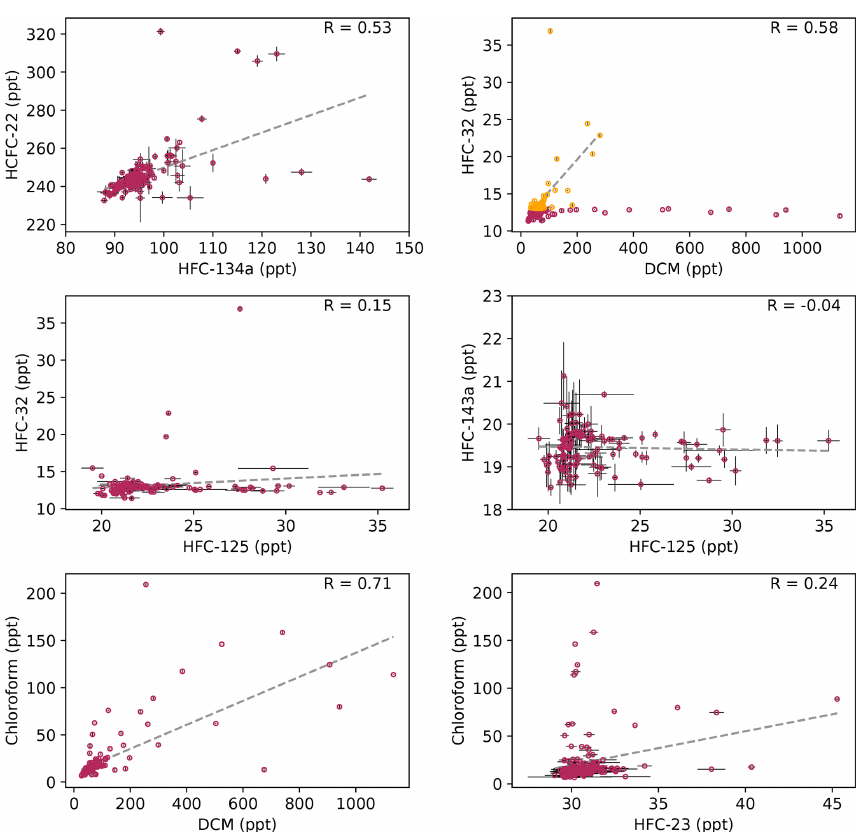
Figure 3. Halocarbon scatter plots, shown with line of best fit and Pearson ( R ) correlation coefficient. For HFC-32 versus DCM, the sub- scatter shown in orange is a subset of the dataset corresponding to samples whose HFC-32 mole fraction (lower bound of measurement uncertainty) exceeded the 20th percentile of all measurements (and were hence classified as enhanced), since there are likely other sources of DCM not linked to HFC-32